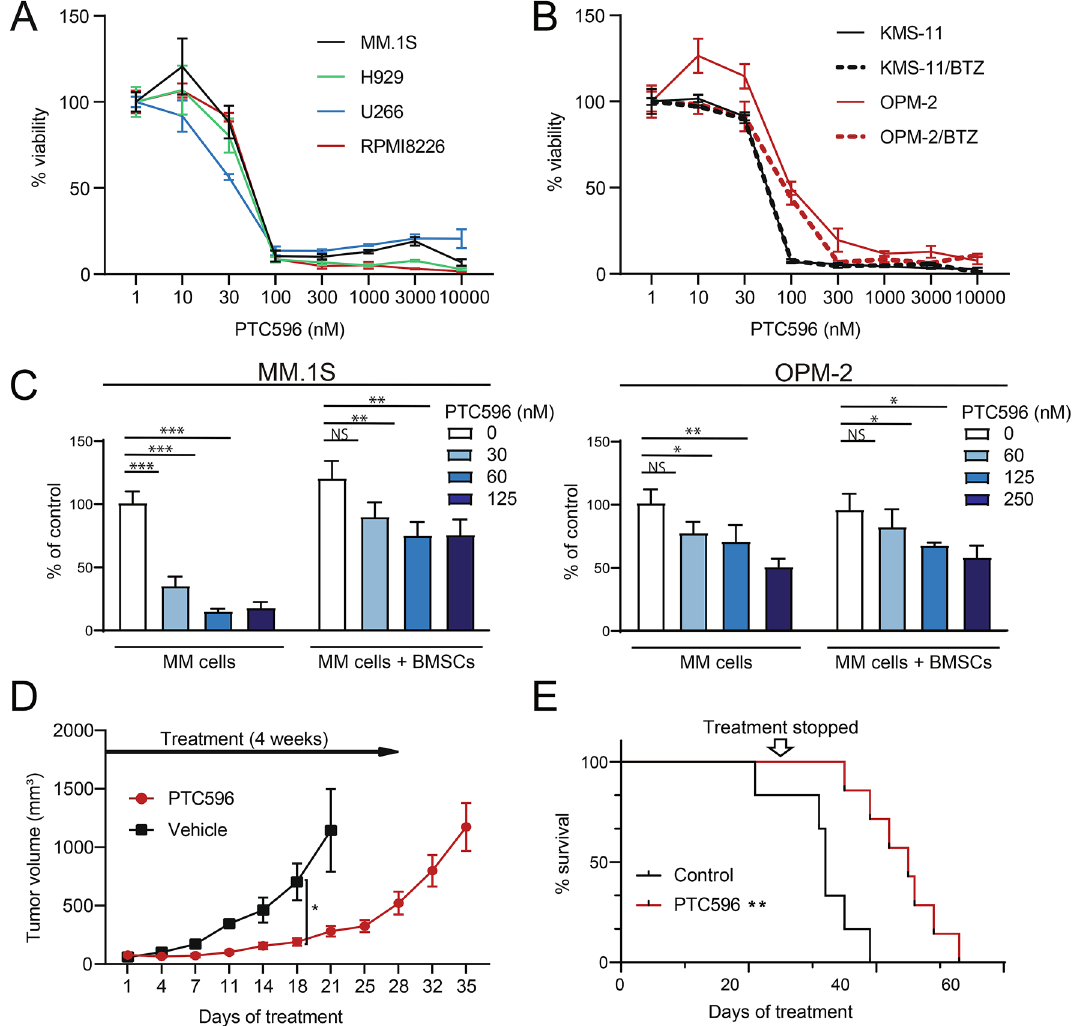
Figure 1. PTC596 inhibits the growth of MM cells both in vitro and in vivo. ( A , B ) MTS assays of ( A ) MM.1S, H929, RPMI8226, U266, and ( B ) KMS-11, KMS-11/BTZ, OPM-2, OPM-2/BTZ treated with the indicated doses of PTC596 for 72 h. The y-axis presents percent viability relative to the untreated control. Data are shown as means ± SD of triplicate or quadruplicate samples. ( C ) Cell proliferation assays evaluated by BrdU incorporation of MM.1S and OPM2 cells co-cultured with or without BMSCs isolated from patients with MM upon treatment with the indicated doses of PTC596 for 48 h. BrdU was added to the culture 2 h before the analysis. Y-axis is presented as proliferation rate relative to an untreated control. Data are shown as mean ± SD of triplicate samples. * P < 0.05; ** P < 0.01; *** P < 0.001; ns, not significant by a one-way ANOVA. ( D , E ) In vivo analysis of the cytotoxicity of PTC596 using a murine xenograft model of human myeloma MM.1S cells. NOG mice were injected subcutaneously on the right side of the back with 4 × 10 6 MM.1S cells. After the tumor grew to a measurable size, treatment was initiated. Mice were treated with oral PTC596 (12.5 mg/kg) (n = 7) or control vehicle (n = 6) twice a week for 4 weeks. ( D ) Tumor volumes were monitored twice a week. Data represent mean ± SEM. * P < 0.05 using Student’s t -test. ( E ) Kaplan–Meier survival of mice. The mice were sacrificed when the tumors reached 2000 cm 3 or an ulcer occurred. Survival was evaluated from the first day of treatment to death. The statistical significance of differences between PTC596-treated and vehicle-treated groups was determined using a log-rank test. ** P < or additive cytotoxic effects on MM cells when those were co-cultured with BMSCs (Supplementary Fig. S3A, Supplementary Table S2D). We next performed Annexin V staining to evaluate apoptosis in the combination treatment. Apoptosis induced by PTC596 (50 nM) was significantly augmented by the combination with bort- ezomib (Fig. 3B). Enhanced apoptosis in the combination was confirmed by western blotting; the combination with PTC596 and bortezomib enhanced cleavage of caspases, which was accompanied by a reduction in MCL1 protein levels compared with each single treatment (Fig. 3C). Notably, PTC596 in combination with bortezomib also induced significant cytotoxicity in primary CD138 + cells from the BM of patients with MM compared with bortezomib alone, as evidenced by reductions in Annexin V-negative viable cells (Fig. 3D).